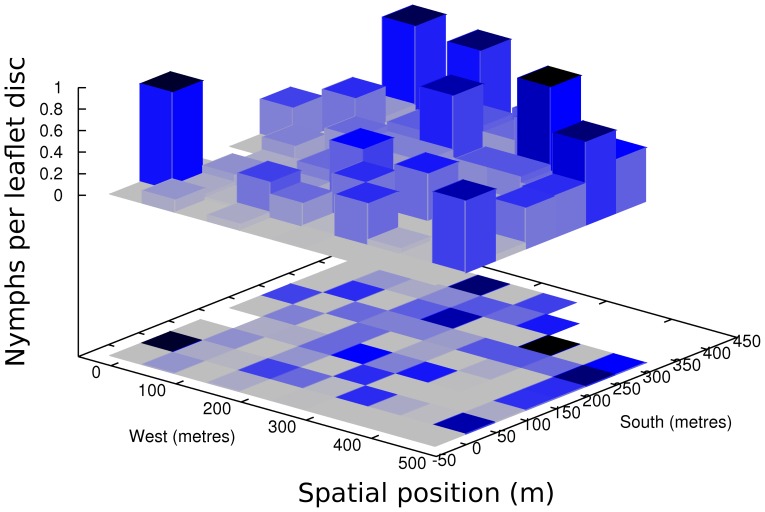
Emergence of whitefly from leaves sampled from release Field 0.The y axis is counts of nymphs per leaflet disc collected on 31 March 2005.